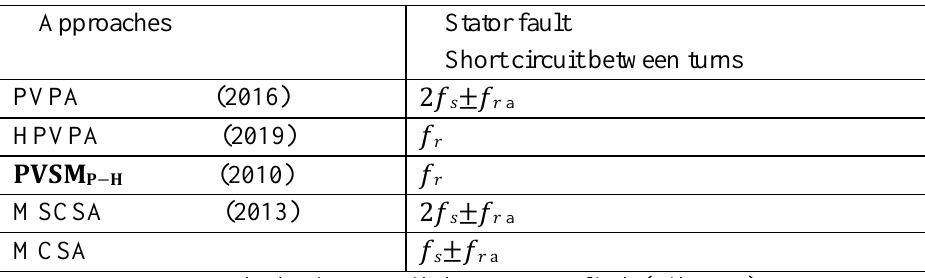
Table 2. Frequencies characteristic of